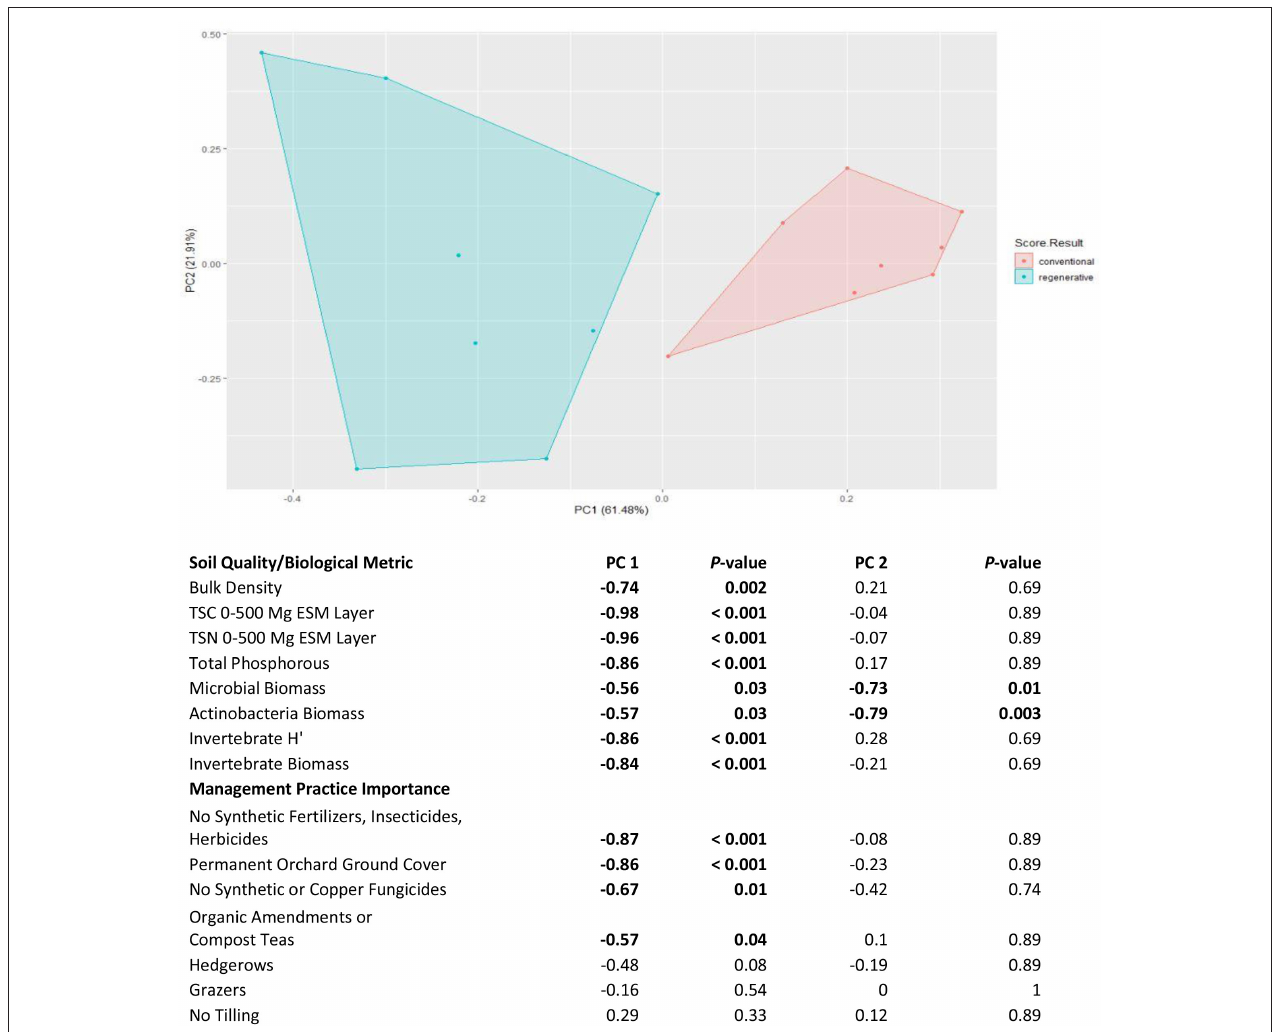
FIGURE 7 | Principle Component Analysis of 16 almond orchards based on eight soil quality and biological community metrics. Blue points represent farms defined as regenerative and red points represent farms defined as conventional in the study. Spearman correlation coefficients are listed for associations of principle components 1 and 2, with soil quality/biological community metrics and with management practice importance. Coefficients in bold indicate significant correlations following False Discovery Rate